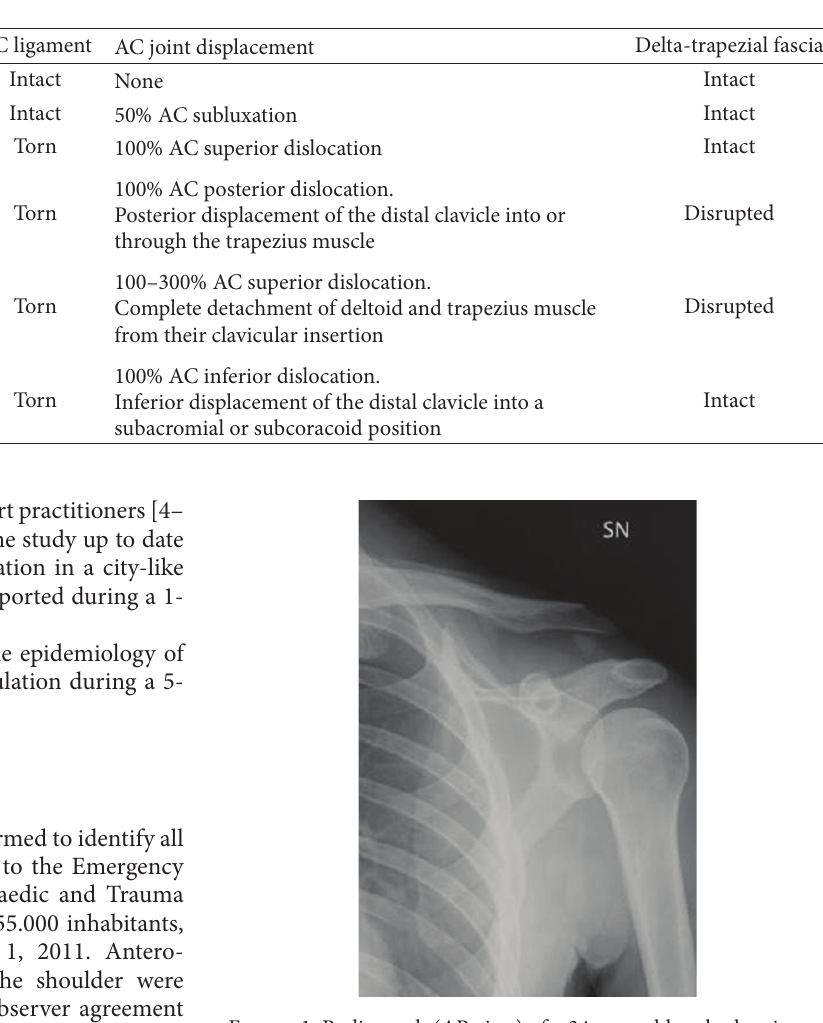
F 1: Radiograph (AP view) of a 34-year-old male showing an ACJ dislocation complicated with a fracture of the lateral third of the